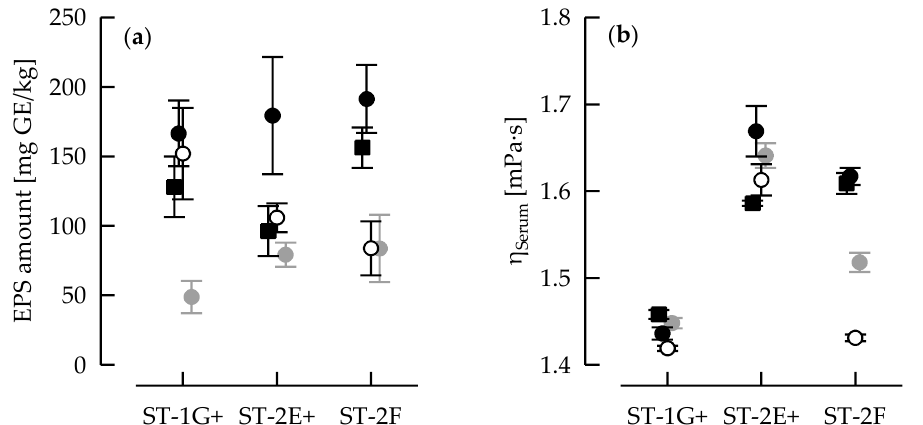
Figure 2. ( a ) EPS amount and ( b ) dynamic viscosity of serum phase ( η serum ) of stirred gels from milk with a C/WP ratio of 4.0:1 after fermentation with low activity starters at 37 °C (white circles). Black circles, similar conditions but fermentation with high-activity starters. Black squares, fermentation with high-activity starters at 42 °C. Grey circles, fermentation of milk with a C/WP ratio of 1.5:1 with high-activity starters at 37 °C. Symbols are slightly shifted along the x-axis for a better visibility.